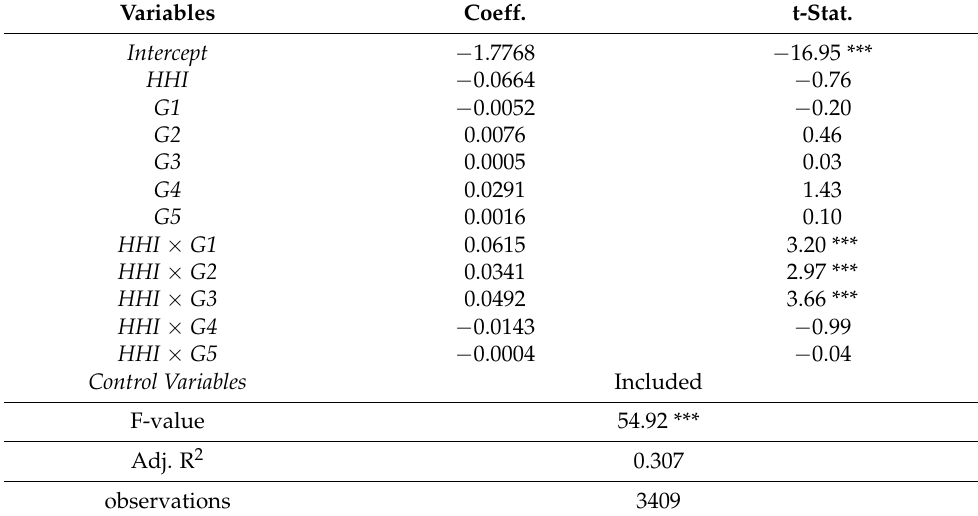
Table 6. The effect of ESG investments. Variables Coeff. t-Stat.